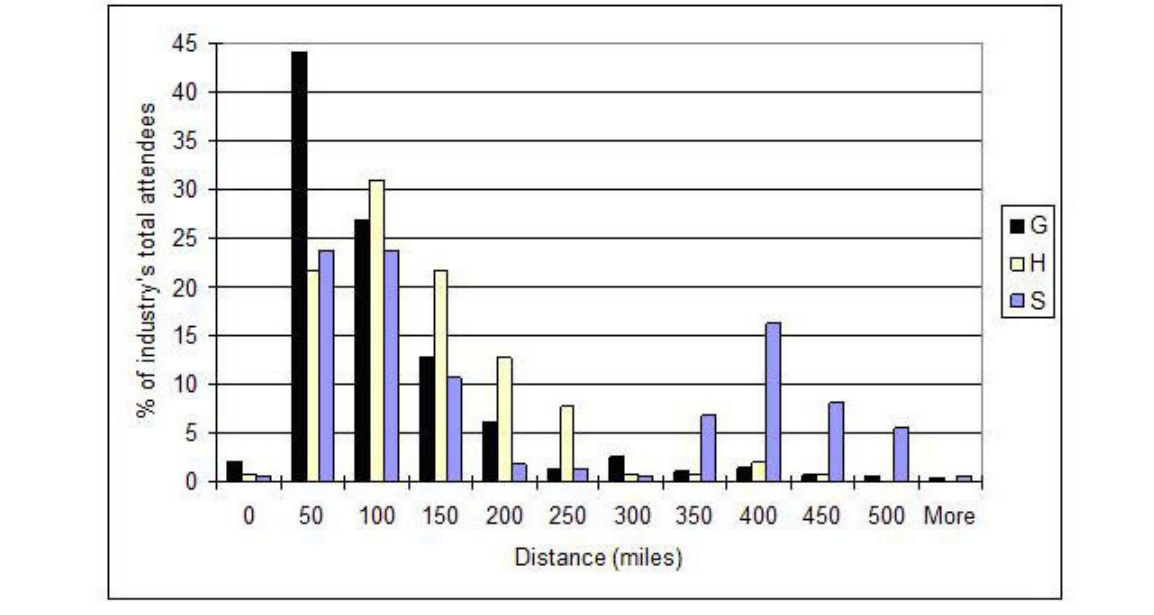
Fig. 7. Industry attendee distances for groundfish, scallop, and herring industries. Data pooled to show the varying amounts across the